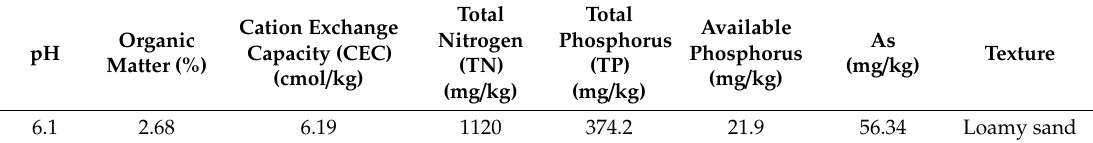
Table 3. Physicochemical properties of soil samples used in column-leaching test.